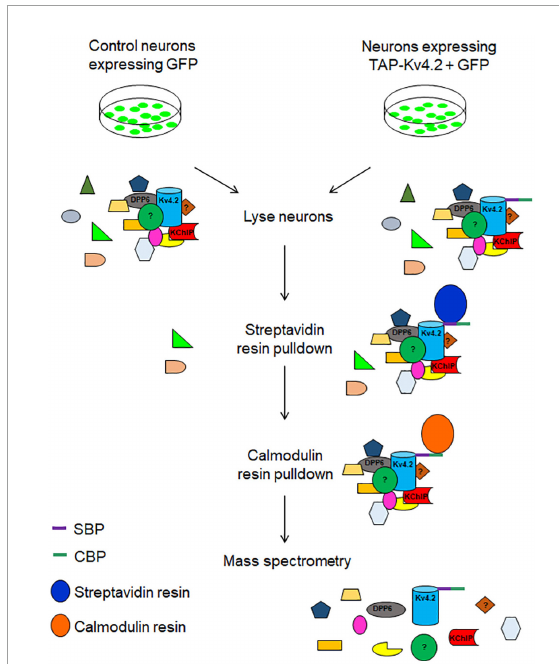
FIGURE1 Schematic diagram of tandem affinity purification (TAP) of tagged Kv4.2 and interacting proteins using streptavidin resin followed by calmodulin resin. Hippocampal neurons expressing GFP or TAP-Kv4.2 plus GFP were lysed and subjected to streptavidin resin pulldown. After elution, samples underwent calmodulin resin pulldown. Pure Kv4.2 complex was isolated from neurons that express TAP-Kv4.2, while in control neurons, background proteins were removed. Purified samples were analyzed for mass spectrometry. DPP6 and KChIP are known binding proteins of